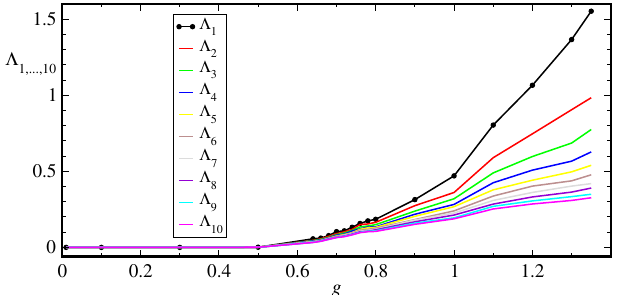
FIG. 1. The ten largest global Lyapunov exponents are ordered in the standard manner in descending order. The simulations have been performed for the same parameter values as in the paper, i.e., δ ¼ 0 . 1 , N ¼ 64 000 , and decreasing g for a given realization of the frequencies.